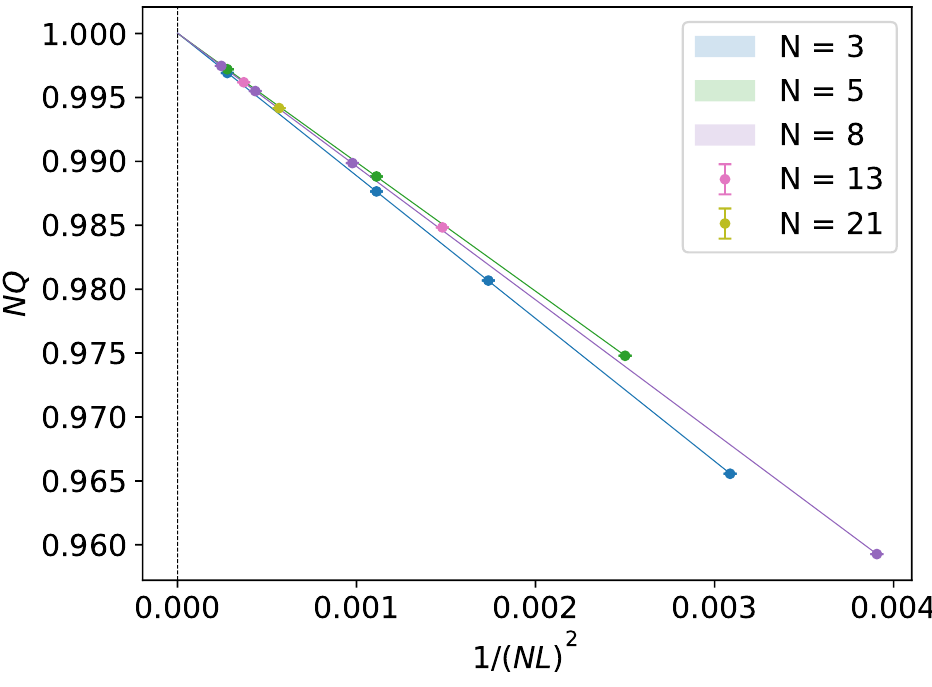
Figure 1. Continuum extrapolation of ( N -times) the topological charge: NQ . Data is extracted from table 1 and is extrapolated to the continuum with a 2 = 1 / ( NL ) 2